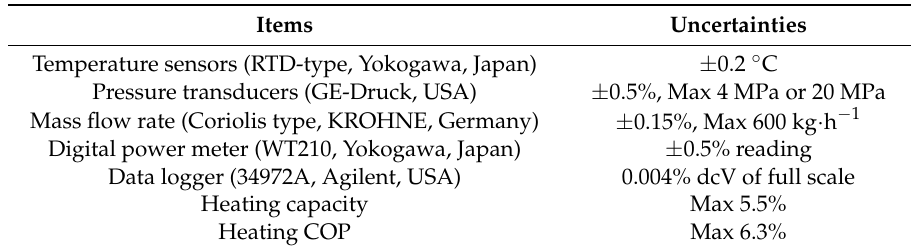
Table 2. Uncertainties of the experimental parameters and measured data.